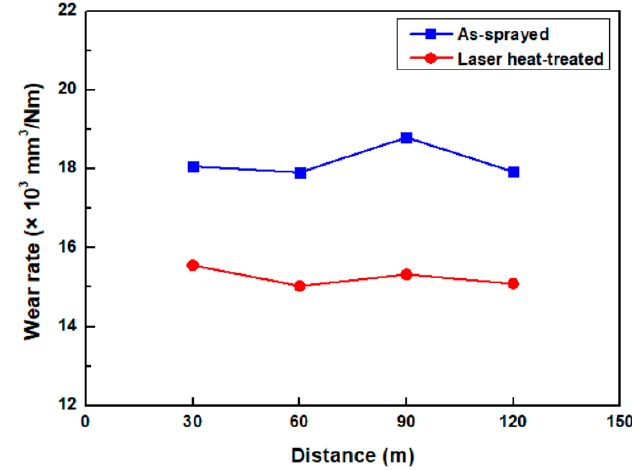
Figure 14. Measured wear rate of the as-sprayed coating and laser heat-treated coating at 1473 K at every 30 m of wear distance.